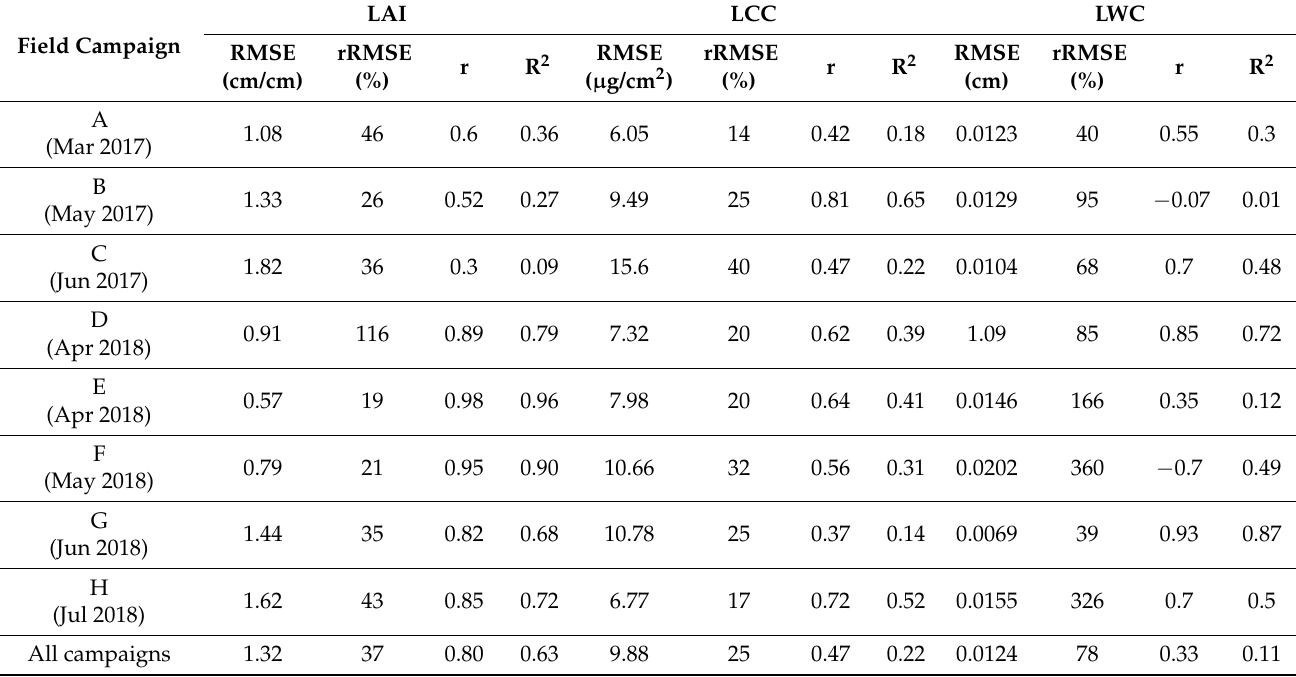
Table 6. Validation of LAI, LCC, and LWC estimations against in situ data: campaign level results (statistics aggregated by terms of campaigns across all crop